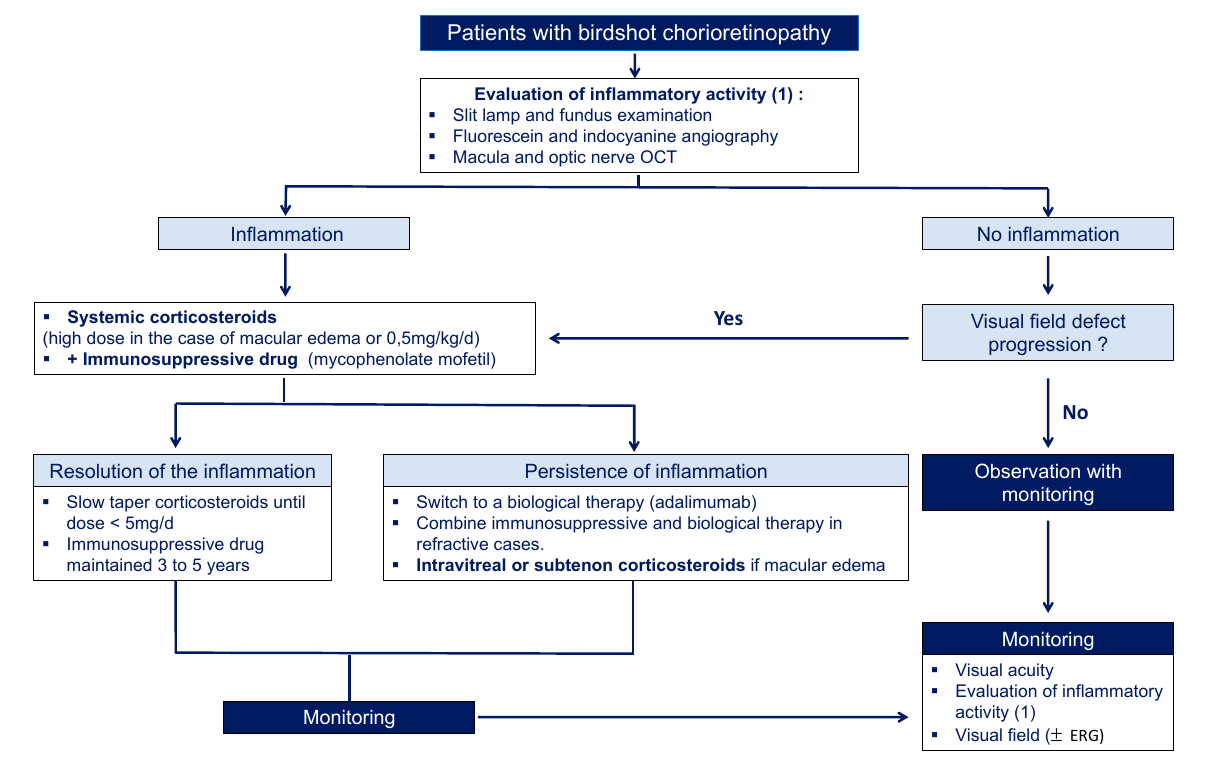
Figure 6. Treatment and monitoring algorithm proposed by the authors based on the literature review and the authors’ experience.